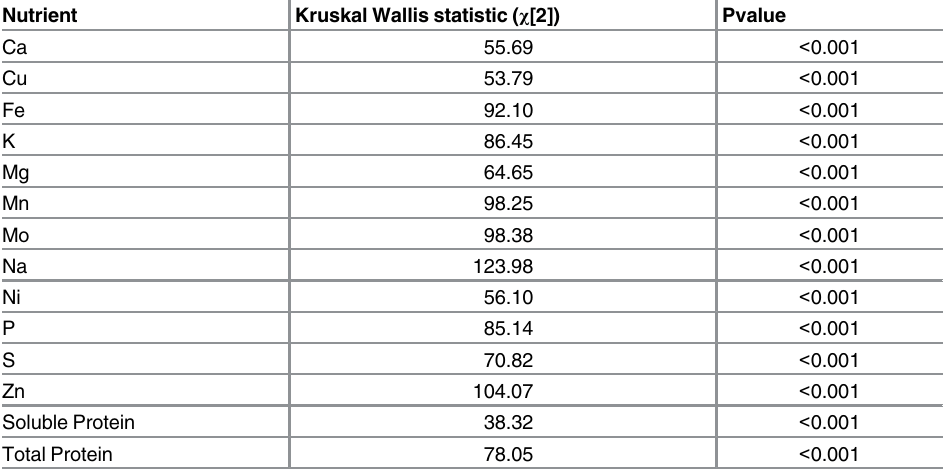
For all tests there were 12 degrees of freedom, except those for protein, for which there were 11 d.f. as a result of excluding the rachis of M . peregrina from the